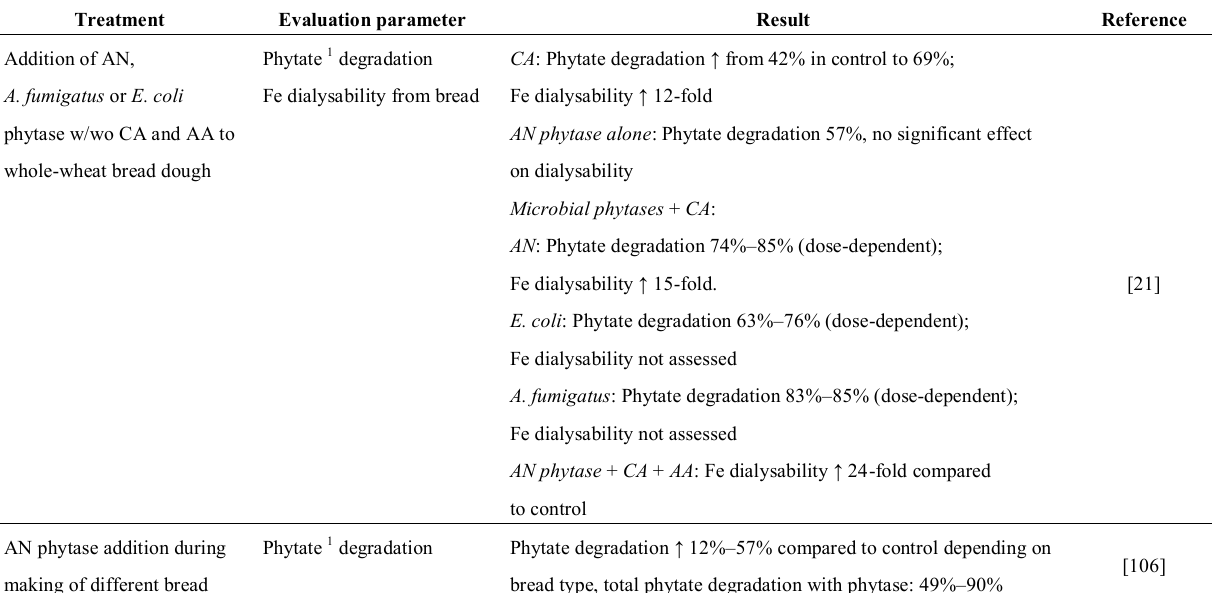
Table 4. Condensed results from studies employing ex vivo phytase catalysis evaluated on in vitro parameters. Abbreviations: CA: citric acid; AA: ascorbic acid; AN: Aspergillus niger ; InsP: myo -inositol phosphate; InsP6: phytate; InsP5: myo -inositol pentaphosphate; InsP3: myo -inositol triphosphate; w/wo: with/without.